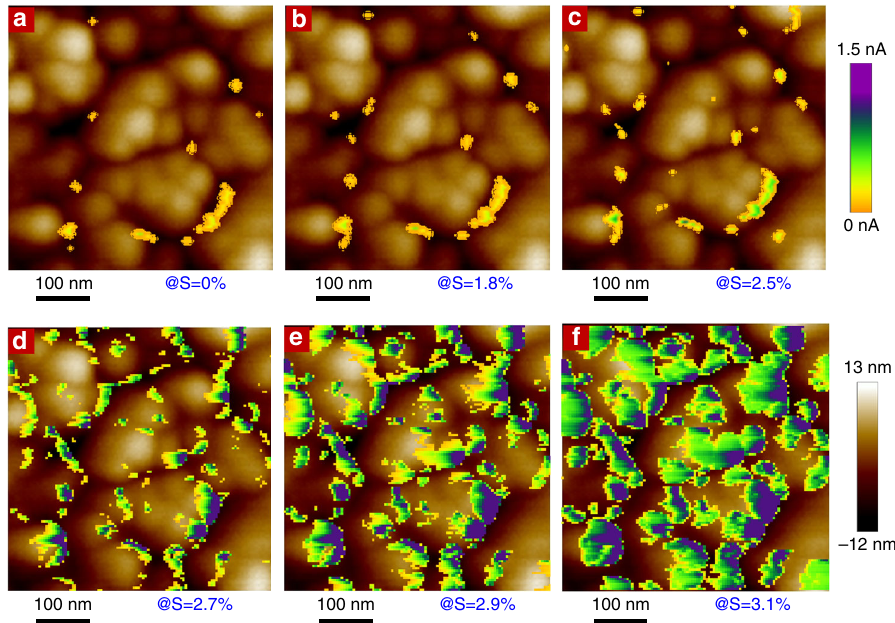
Fig. 4 Microscopic current and topography maps of the I 2 @CuTCA nano fi lm. a – c With the bending strains under 2.5%, the conductive regions of the particulate metal-organic framework nano fi lm merely appear at the grain boundaries. d – f When the bending strain exceeds 2.5%, the conductive regions gradually extend into the entire nanograins with their local conductivity increasing simultaneously and